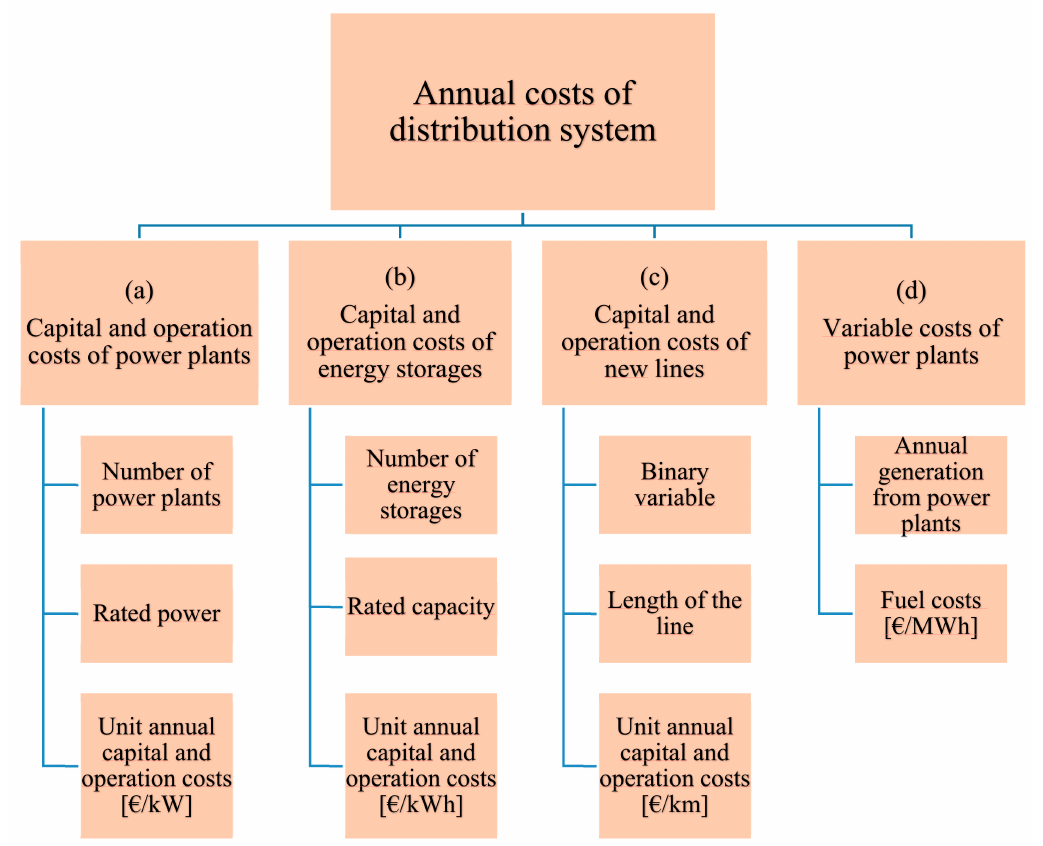
Figure A3. Scheme of the objective function.